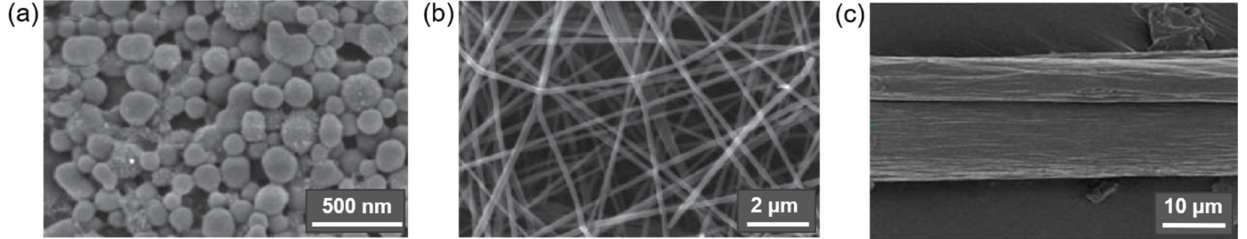
Figure 3. SEM images of ( a ) ANC from CMC (reproduced from [76] under the terms of the Creative